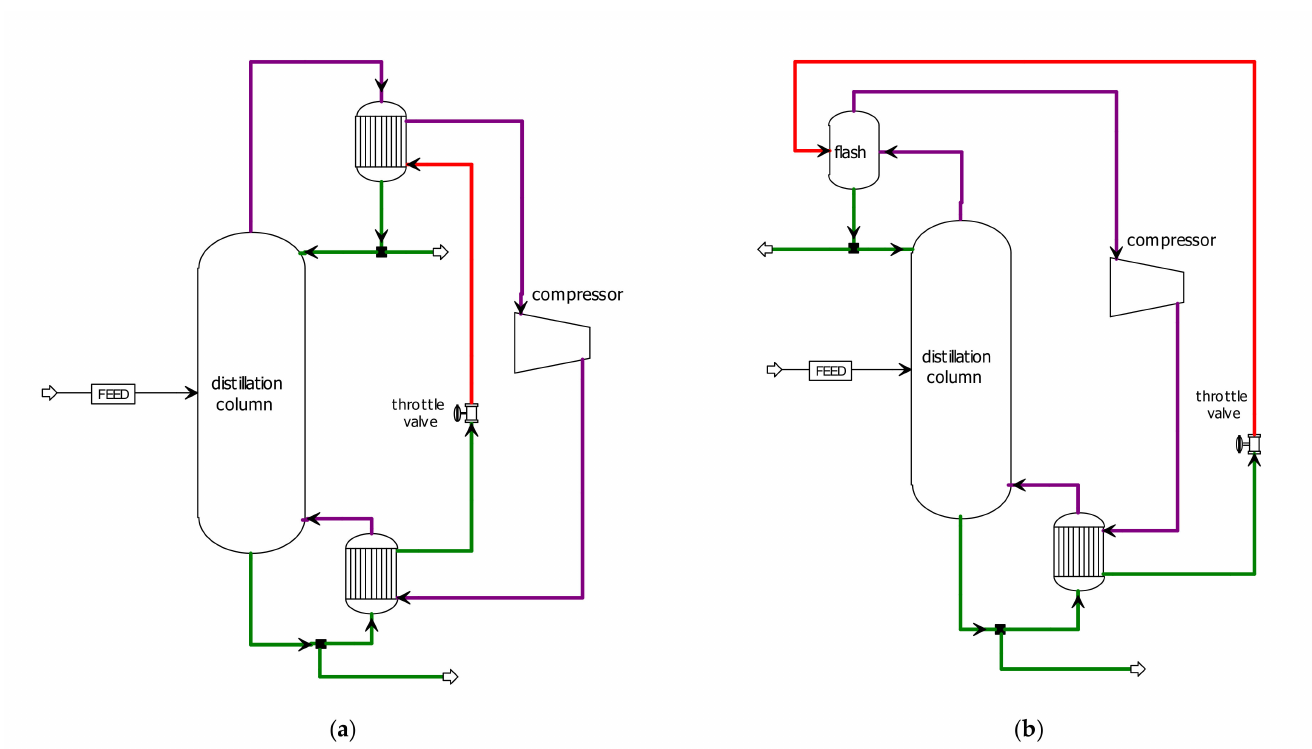
Figure 1. Heat pumps schemes: ( a ) Vapor compression heat pump; ( b ) Mechanical vapor recompression heat pump. Stream condition: green—liquid at boiling temperature; red—vapor-liquid mixture; purple—saturated/overheated